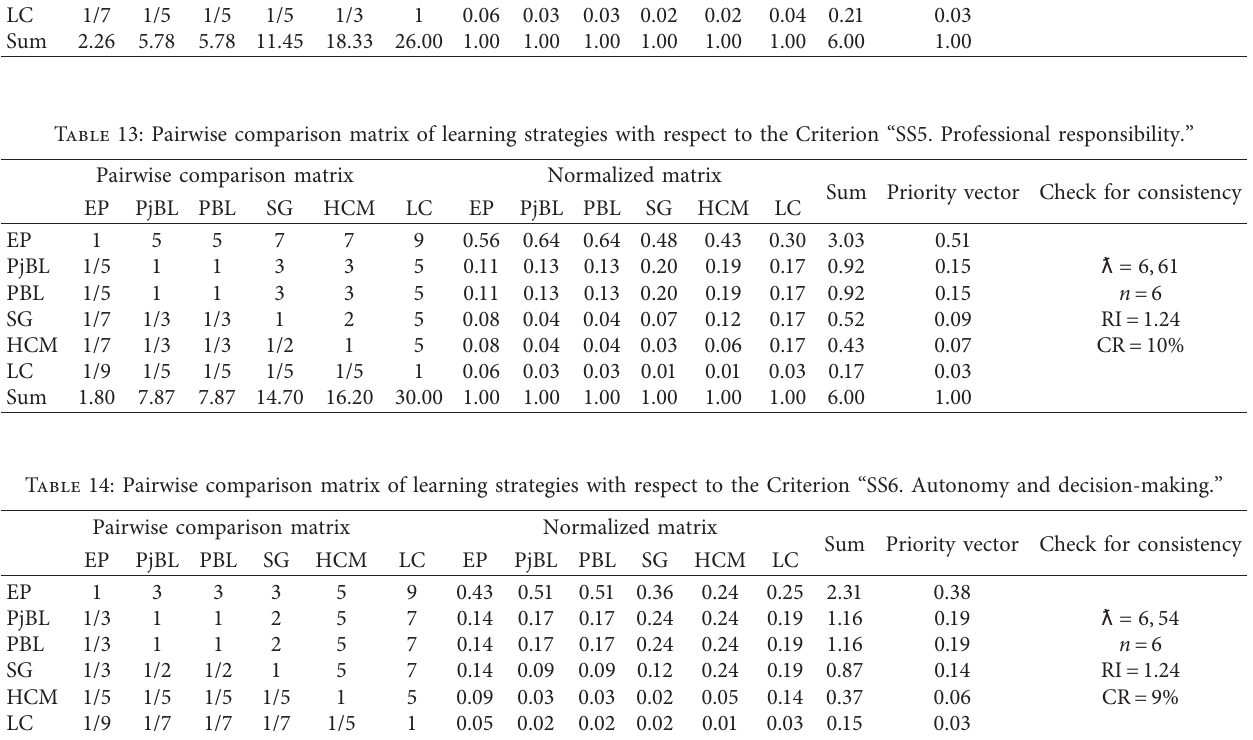
Sum Priority vector Check for consistency